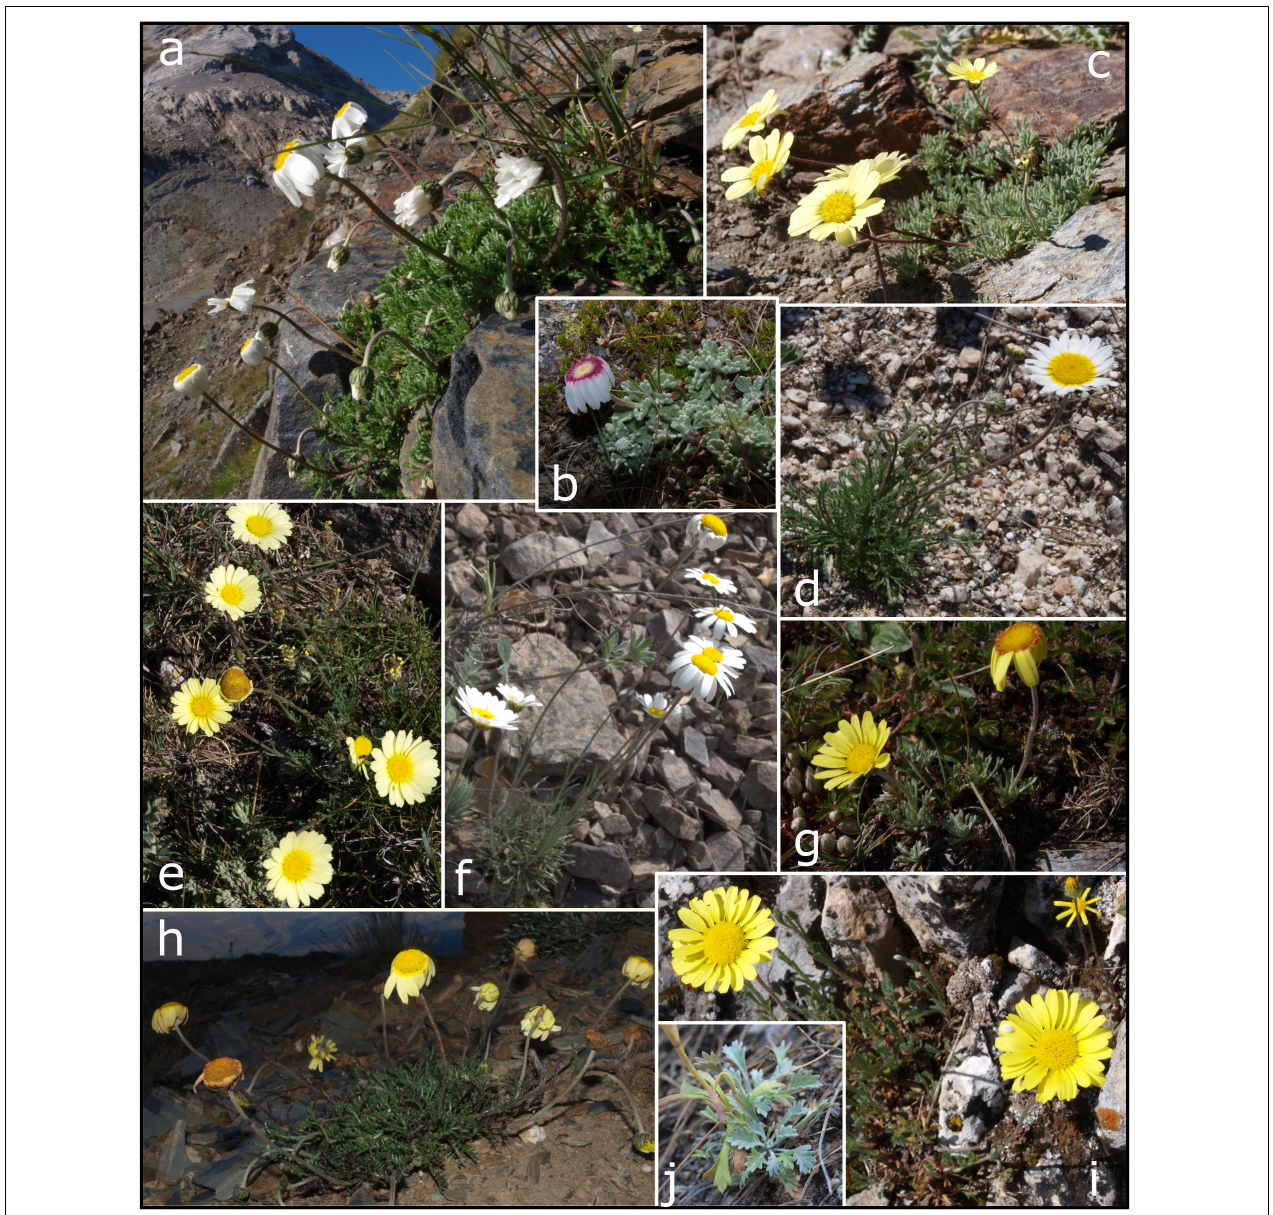
FIGURE 2 | Morphological diversity in Leucanthemopsis : (a) L. alpina subsp. pyrenaica (Port de Boucharo, Hautes-Pyrénées, France); (b) L. alpina subsp. tomentosa at Monte Renoso (Corsica, France). (c) L. pectinata at Veleta peak (Granada, Spain). (d) L. pulverulenta at Puerto de Villatoro (Avila, Spain). (e) L. pallida subsp. pallida at Puerto de Villatoro (Avila, Spain). (f) L. pallida subsp. virescens at Sierra de Vicort (Zaragoza, Spain). (g) L. cuneata subsp. valdes-bermejoi at Sierra del Brezo (Palencia, Spain). (h) L. flaveola at Peña Trevinca (Orense, Spain). (i) L. spathulifolia at Sierra de Cazorla (Jaén, Spain), and (j) detail of the spathulate basal leaves. Photos by Salvatore